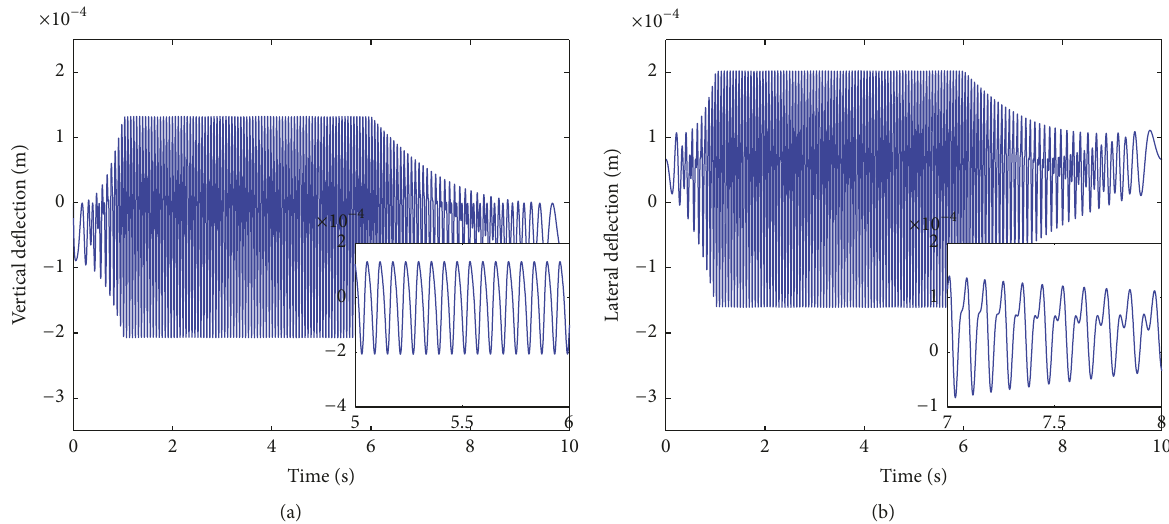
Figure 7: Tip deflection with zoom in steady state in vertical (a) and with zoom in shutdown regime in lateral (b) directions for the total model.